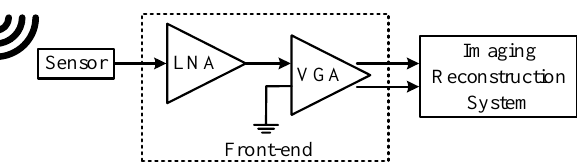
Figure 14. Block diagram of the HFUS and PA imaging front-end.